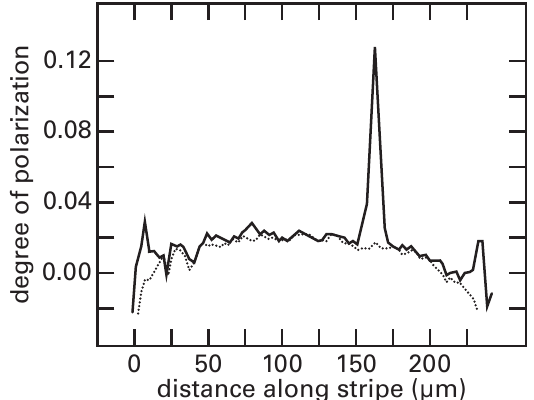
Figure 6. DOP along the stripe of a laser, showing a strong, discrete scattering centre. Adapted with permission from Figure 4 of [30] ©The Optical Society.